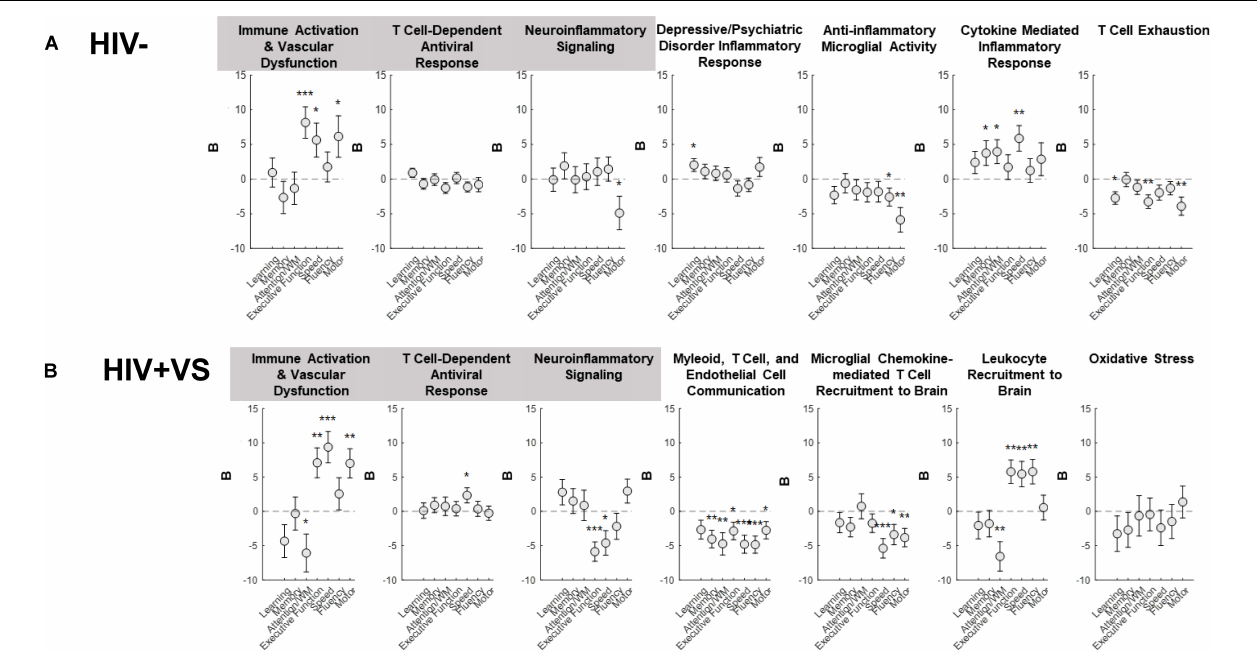
FIGURE 2 | Associations between inflammatory profile scores and domain-specific cognitive performance at a subsequent point in time among (A) HIV- uninfected (HIV-) woman and (B) virally suppressed women with HIV (HIV + VS). WM, working memory; * p < 0.05; ** p < 0.01; *** p < 0.001. Circles denote the unstandardized beta weights (B) and standard errors of (B) . Circles above 0 indicate positive associations whereas circles below 0 indicate negative associations. Inflammatory signatures highlighted in gray are common to both HIV– and HIV+ VS women whereas inflammatory signatures not highlighted in gray are specific to either HIV– or HIV+ VS